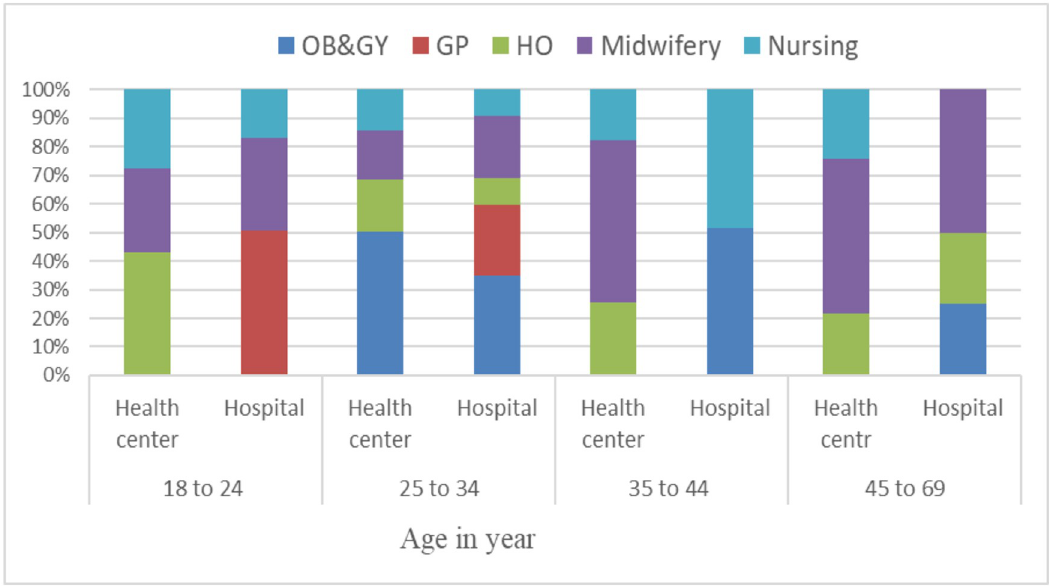
Fig 2. The proportion of good knowledge by profession and Health facility in PPIUCD in Amhara regional state health facility, Ethiopia, (2016).